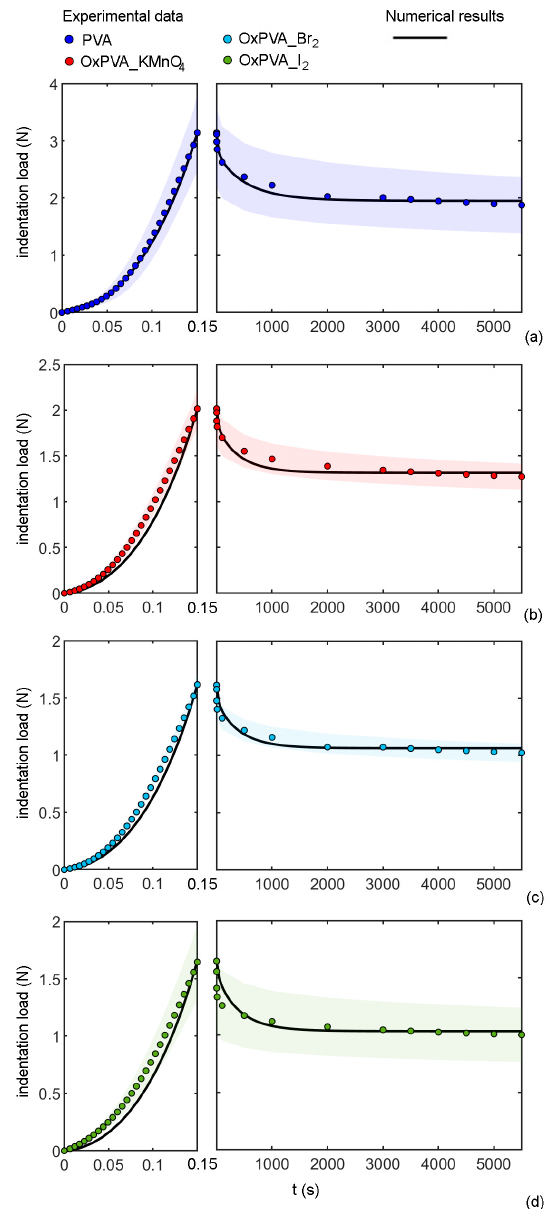
Figure 5. Comparison between experimental data and numerical results of indentation and consoli- dation tests for native and oxidized PVA hydrogels: indentation load (mean and confidence interval) vs. time for ( a ) PVA, ( b ) OxPVA_KMnO4, ( c ) OxPVA_Br 2 , and ( d ) OxPVA_I 2